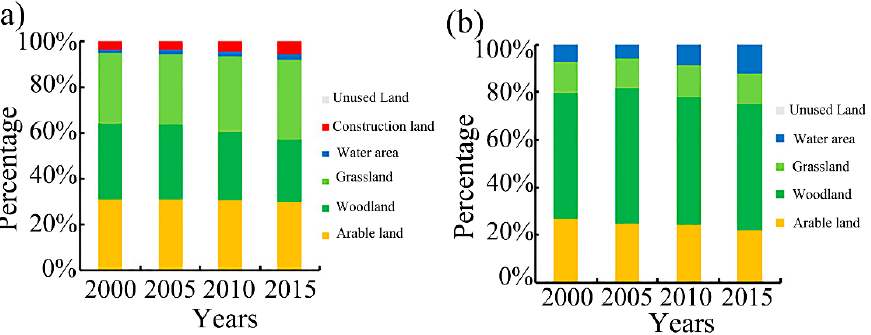
Figure 3. The percentage of land-use/cover by area ( a ) and by ecosystem services value ( b ) in the Qihe watershed.